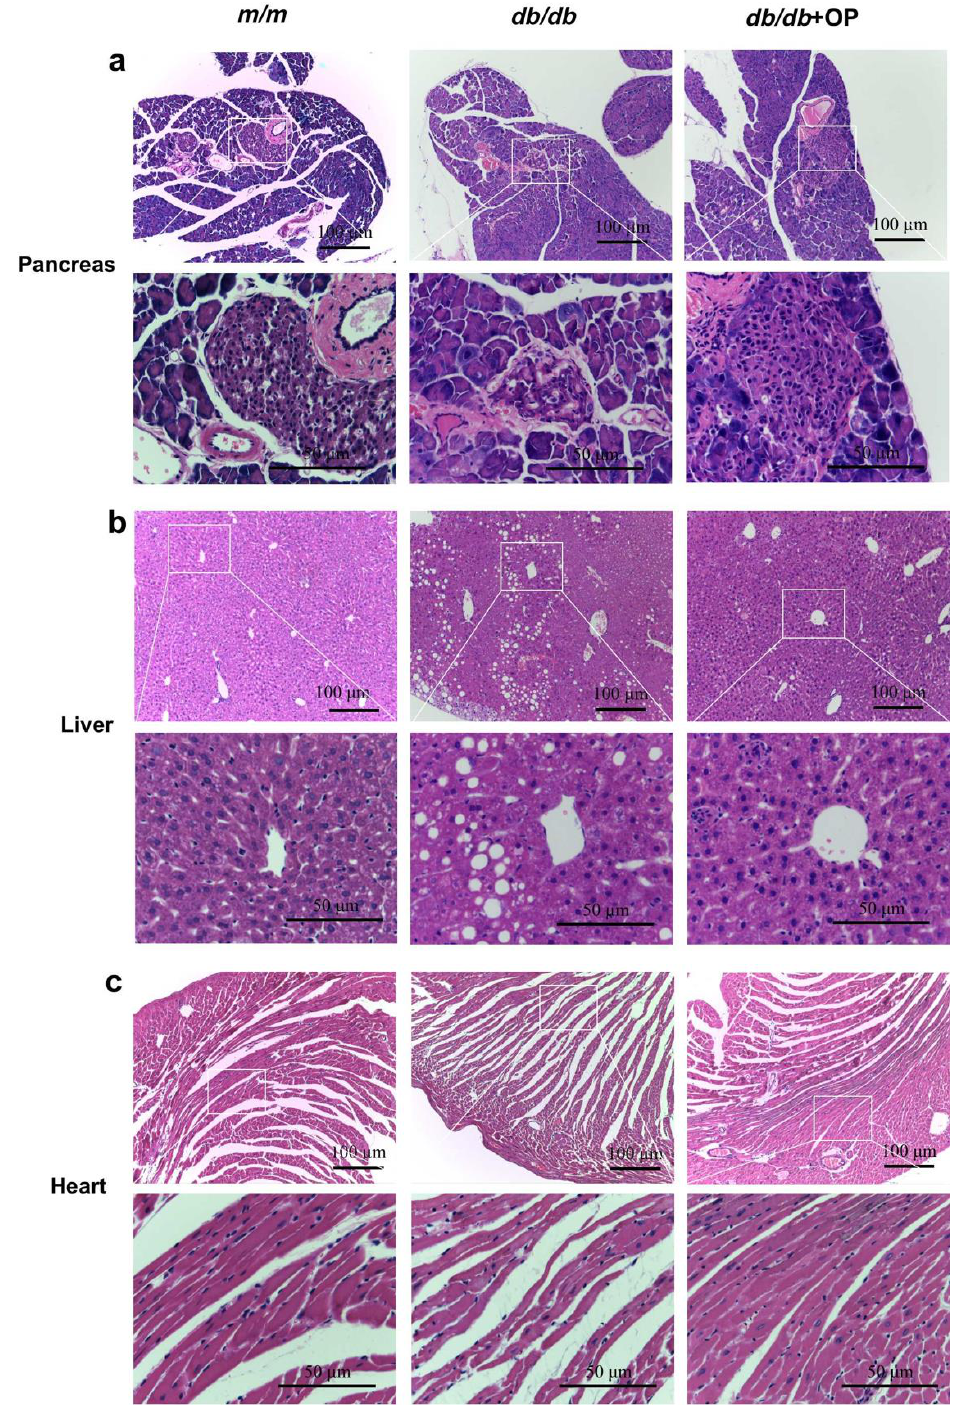
Figure 2. Microphotographs of H&E-stained ( a ) pancreas, ( b ) liver, and ( c ) heart from mice (100 × magnification, scale bar = 100 μm; 400× magnification, scale bar = 50 μm). The rectangular frame was manually added, and the details were displayed at a higher magnification.